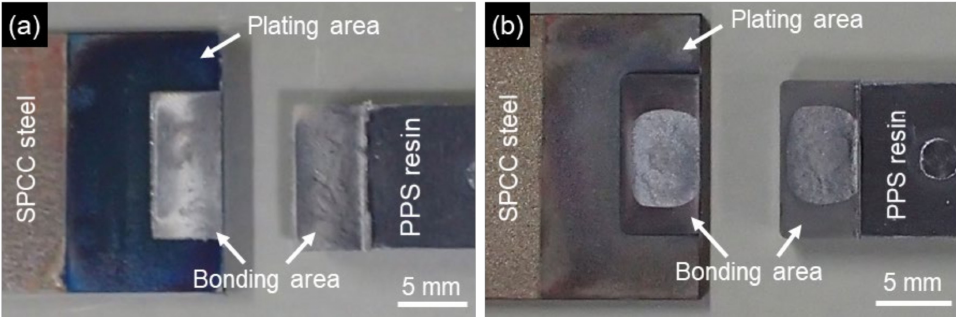
Figure 11. Photographs of fracture surfaces of bonded samples: ( a ) Before heat shock testing (1000 cycles); ( b ) After heat shock